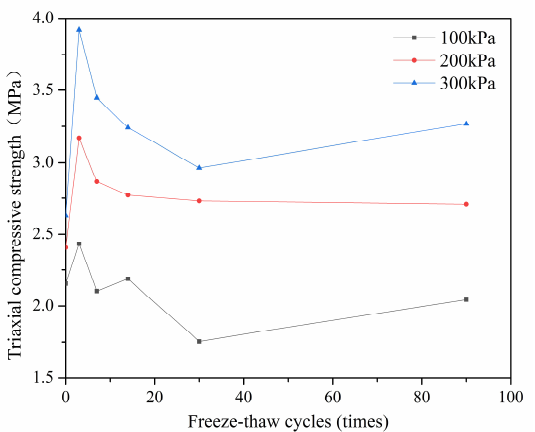
Figure 6. The variation of triaxial compressive strength in S/S lead-zinc-cadmium composite HM soil with different F-T cycles under three different confining stresses.